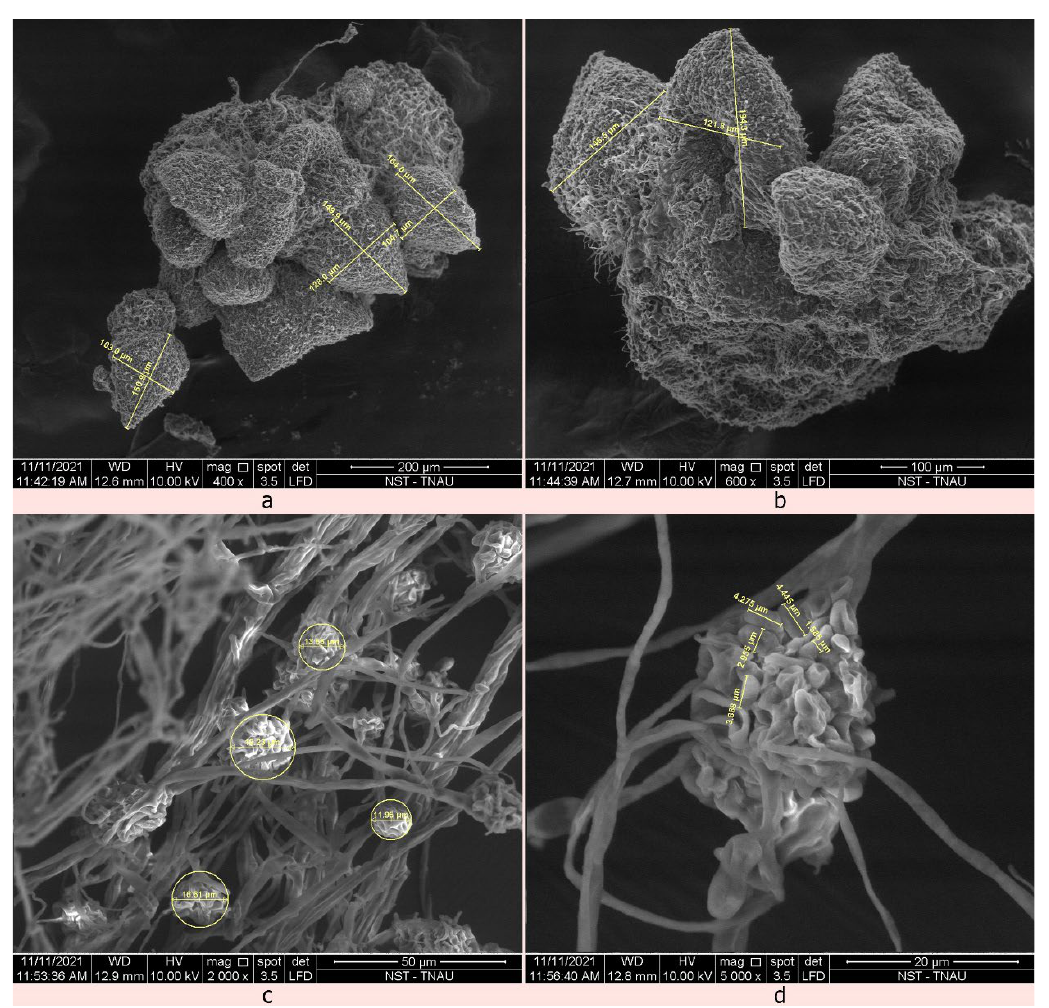
Figure 4. Structural components of C. rosea TNAU-CR 02 isolate. ( a , b ) Irregular-shaped sporodochia ( a ) 400 × magnification; 200 µ m and ( b ) 500 × magnification; 100 µ m). ( c , d ) Conidiophore with conidia ( c ) 2000 × magnification; 50 µ m and ( d ) 5000 × magnification; 20 µ